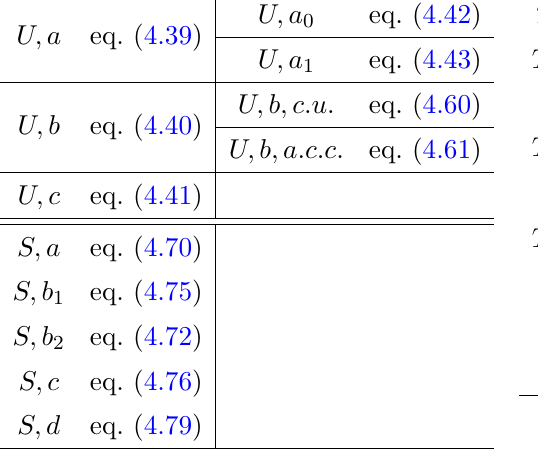
arrows represent the transition from an integrated quantity to its unintegrated counterpart by means of the insertion of an unresolved gluon. Two disjoint red arrows indicate the iterated insertion of two unresolved gluons, while two connected red arrows indicate the simultaneous insertion of two unresolved